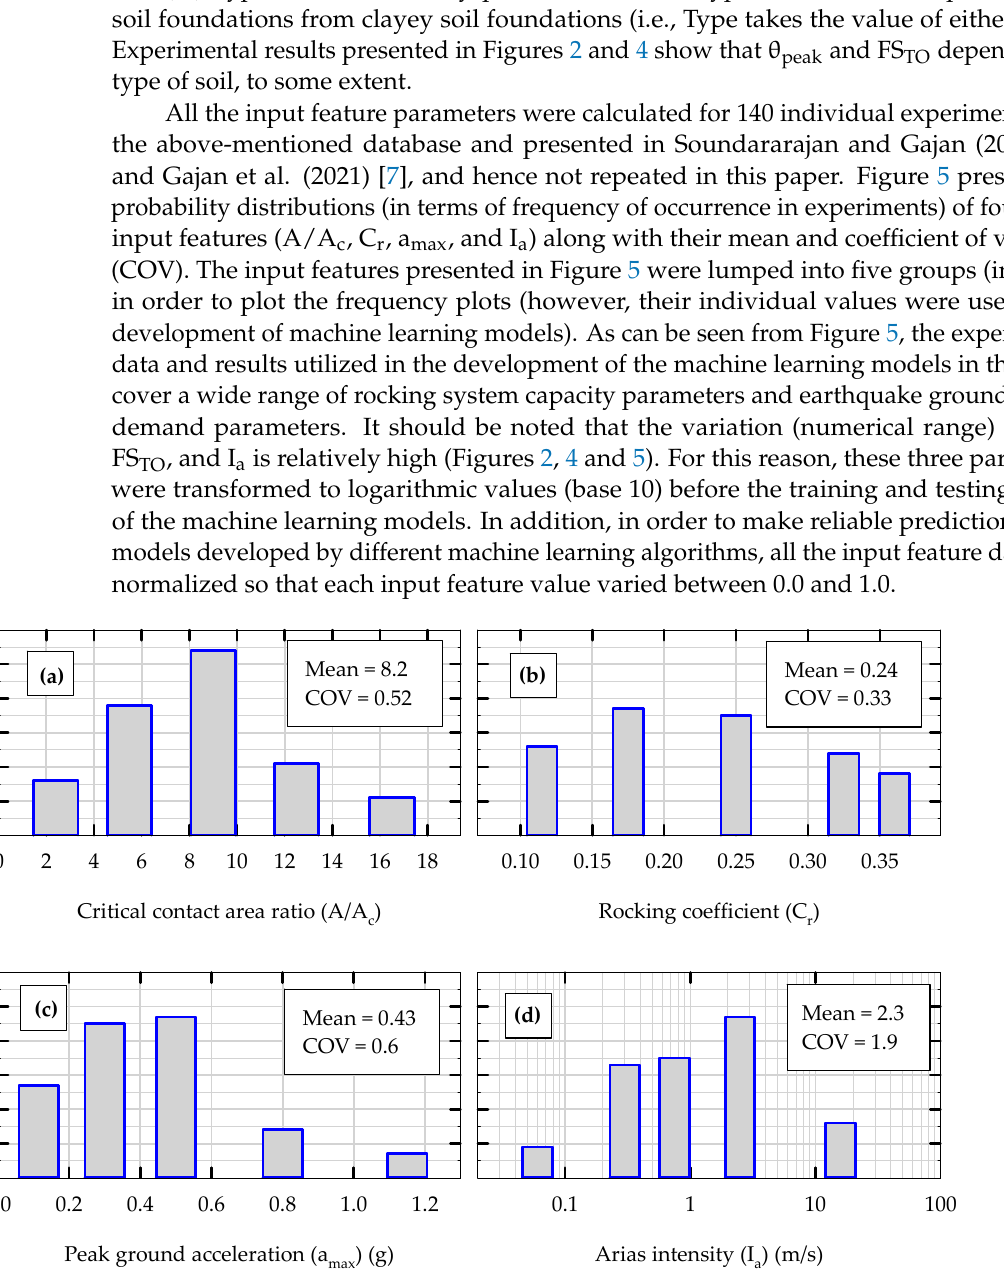
Figure 5. Probability distributions (frequency of occurrence in experimental data instances) of four of the six input features used in the development of machine learning models.